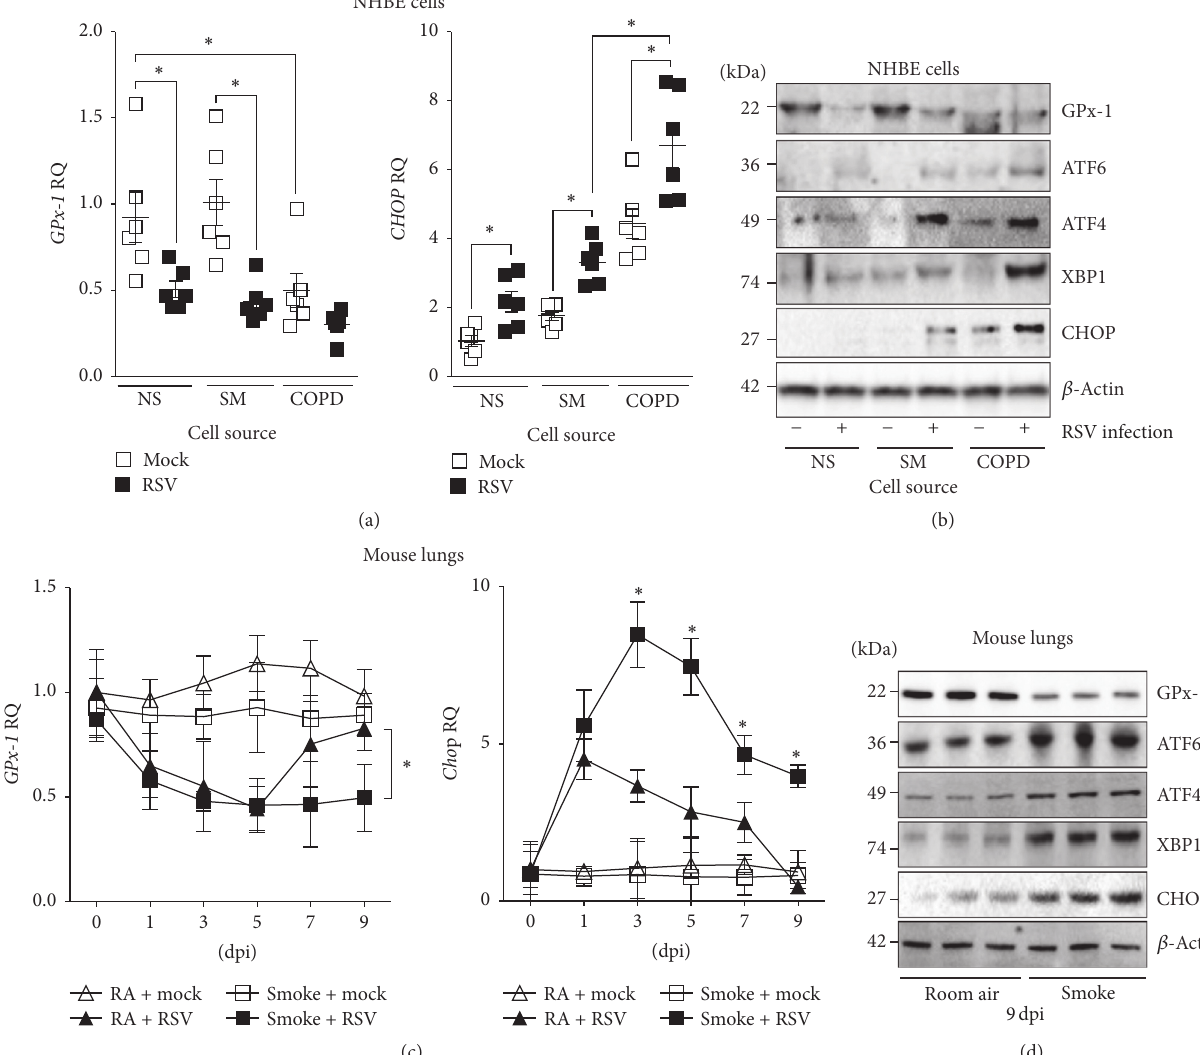
Figure 4: RSV infection enhances the UPR in the lung. (a) GPx-1 and CHOP gene expression were determined in NHBE cells isolated from nonsmoker (NS), smokers (SM), and COPD (COPD) individuals ( 𝑛 = 6 donors per group) infected with mock or RSV and analyzed by qPCR. (b) Protein expression of GPx-1, ATF6, ATF4, CHOP, and 𝛽 -actin was examined by immunoblots. (c) Wild type mice were exposed to cigarette smoke or room air for six months and subsequently infected with 1 × 10 6 pfu of RSV. Animals were euthanized at 0, 1, 3, 5, 7, and 9 days after infection (dpi) and Gpx-1 and Chop expression were determined by qPCR. (d) Protein expression of GPx-1, ATF6, ATF4, CHOP, and 𝛽 -actin was examined by immunoblots. Data are shown as mean ± SEM, where each measurement was performed on 3 independent days. ∗ denotes a 𝑝 value < 0.05, when comparing both treatments connected by a line or the same infection day, determined by Student’s 𝑡 -test (2 groups) or 2-way ANOVA with Tukey’s post hoc test ( > 2